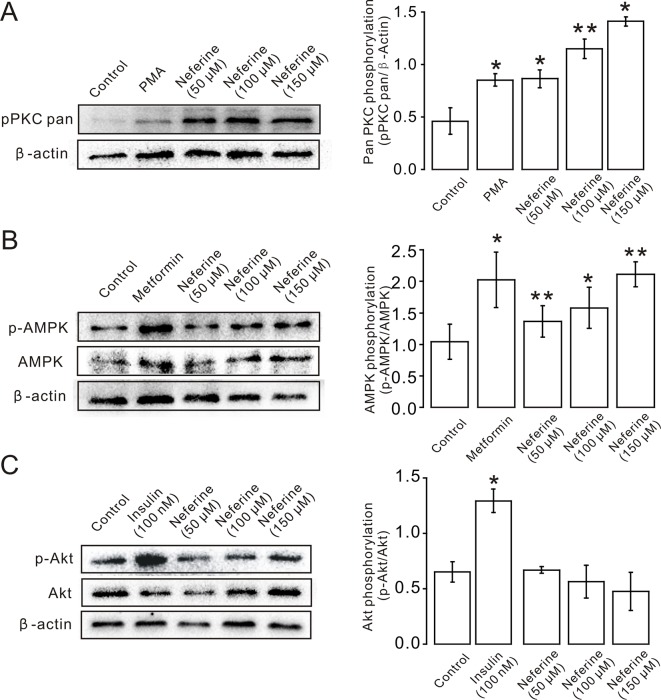
Neferine induces GLUT4 expression in L6 cells by promoting phosphorylation of the PKC and AMPK signaling pathways. (A) Neferine induces an increase (∼1.9-fold at 50 µM, ∼2.5-fold at 100 µM, ∼3.0-fold at 150 µM) in PKC phosphorylation levels after 30 min in a dose-dependent manner. 200 nM PMA (positive control) also increases PKC phosphorylation levels (∼1.8-fold). (B) Neferine increases AMPK phosphorylation (∼1.3-fold at 50 µM, ∼1.6-fold at 100 µM, ∼2.0-fold at 150 µM) in a dose-dependent manner. 100 μg/ml Metformin (positive control) also increases AMPK phosphorylation (∼1.5-fold). (C) Akt phosphorylation is not significantly affected after treatment with 50 µM, 100 µM, or 150 µM neferine. Insulin, however, increases Akt phosphorylation levels. NS P > 0.05; *P < 0.05; **P < 0.01.